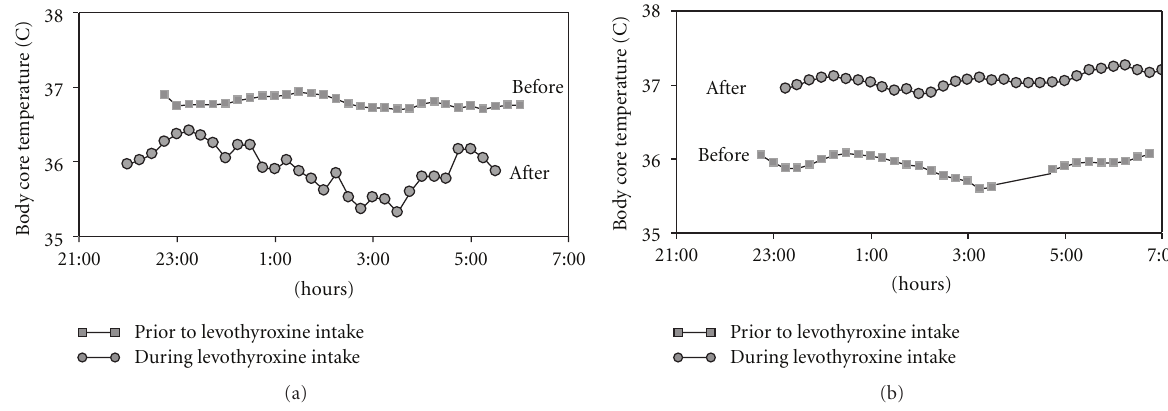
Figure 2: (a) Female subject with a higher core body temperature prior to levothyroxine intake (grey square) than during levothyroxine intake (grey circle). (b) Female subject with a lower core body temperature prior to levothyroxine intake (grey square) than during levothyroxine intake (grey circle). Table 4: Sleep parameters at baseline and during maximal dosage of levothyroxine (L-T4) 1